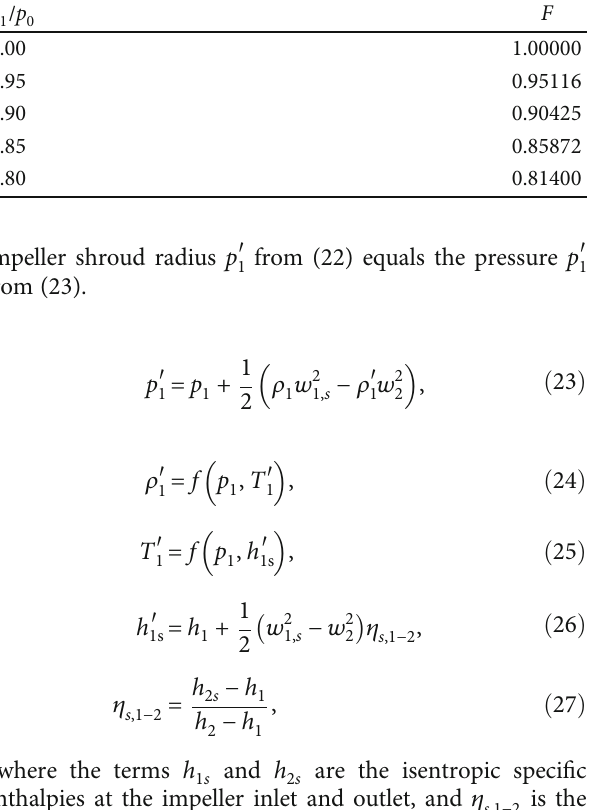
Table 5: Values of the coe ffi cient F in Kearton ’ s theory [9]. p / p 1 0